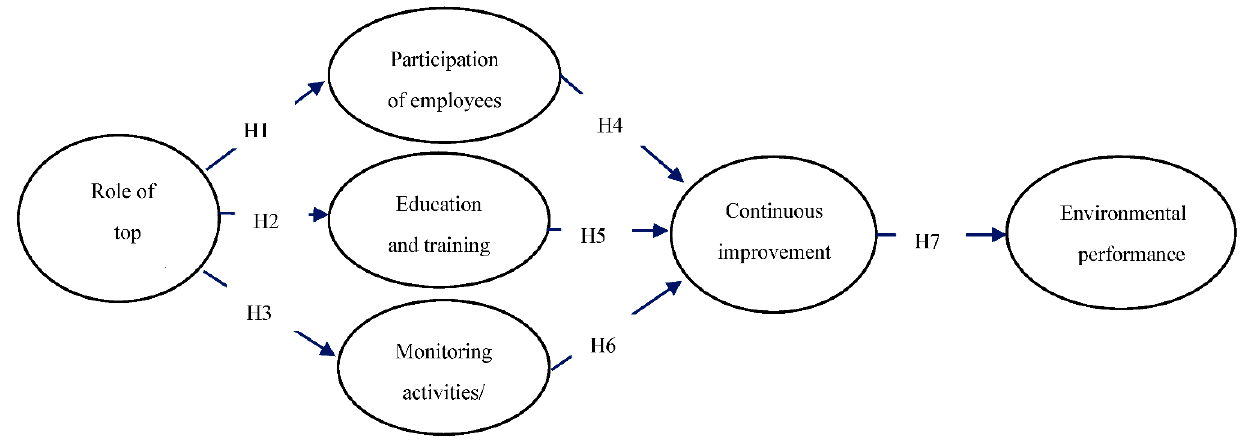
Figure 1. Proposed research model.